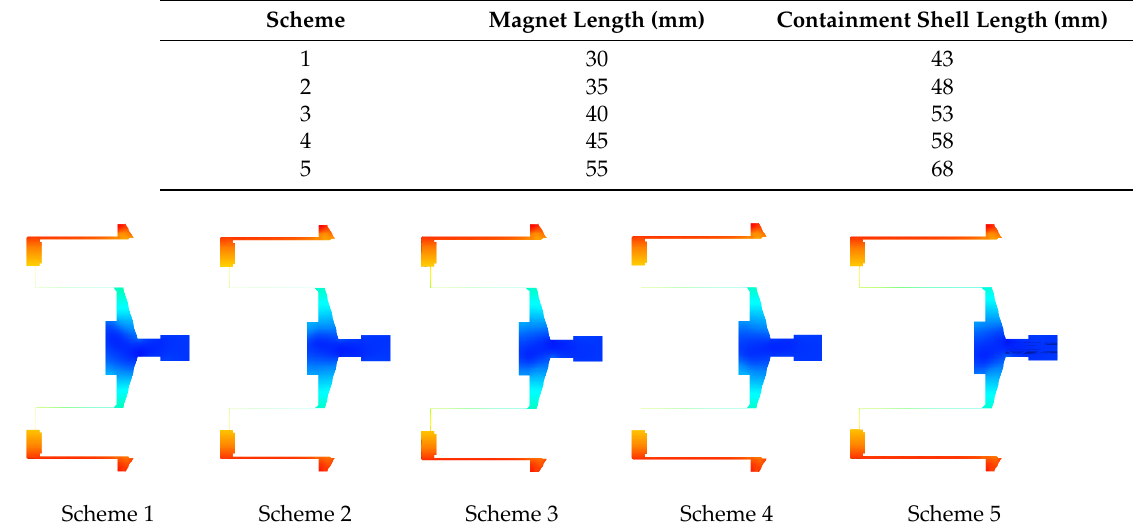
Figure 14. Comparison of the pressure distribution of different schemes.